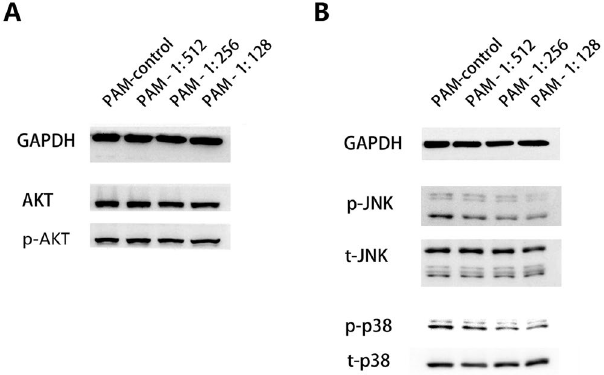
Figure 5. Plasma-activated medium (PAM) inhibits MMP-9 in a MAPK pathway-dependent manner in ES2 cells. After exposure to PAM (at dilution ratios of 1:512, 1:256 and 1:128, respectively) for 24 h, proteins were extracted and analysed using western blotting. ( A ) AKT pathway regulation. Both phosphorylated AKT and total AKT expression were investigated. ( B ) MAPK pathway regulation in ES2 cells with PAM treatment. The two canonical key regulators JNK1/2 and p38 were investigated at both the phosphorylation and total levels. GAPDH was selected as the internal reference. The original full-length blots are presented in Supplementary Figure 3. Three independent experiments were performed for each of the western blotting